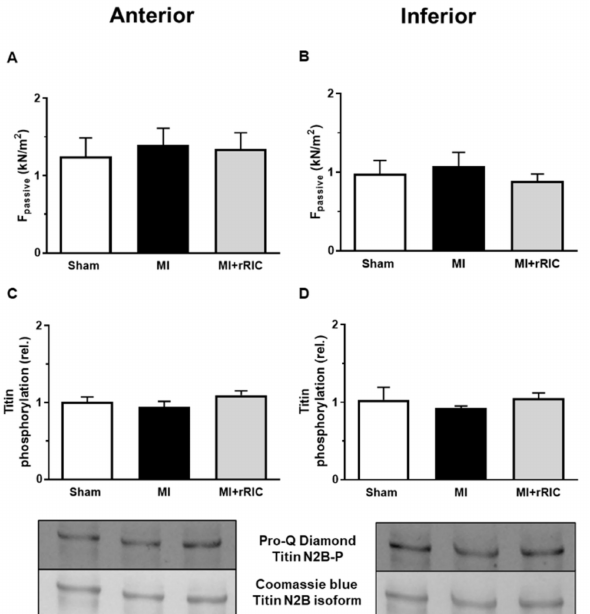
Figure 8. Titin-based passive tension and titin protein phosphorylation in the anterior ( A , C ) and inferior ( B , D ) LV regions. Titin-dependent passive tension (F passive ) in permeabilized cardiomyocytes was determined at a sarcomere length of 2.3 µ m ( A , B ) ( n = 8–10 cardiomyocytes/groups). Total phosphorylation status of the N2B titin isoform was assessed by Pro-Q ® Diamond phosphoprotein staining. Total titin amount was visualized by Coomassie-blue staining ( C , D ). Protein homogenates were collected from four control and six infarcted hearts and assays were repeated four to six times. Data are given as mean ±